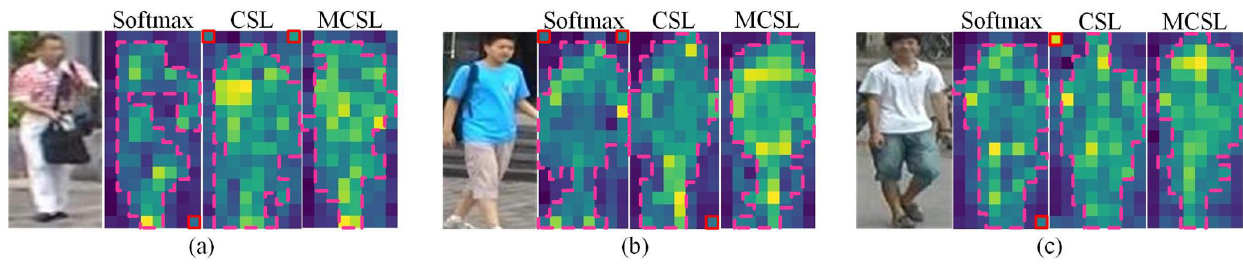
Figure 3. An example of class activation maps of the three input person images ( a – c ) on softmax, CSL, and MCSL functions. Warmer color with higher value. The rough outlines and the backgrounds that are mistaken to the target are marked with pink dotted curves and red boxes,